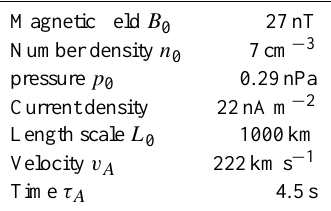
Table 1. Simulation